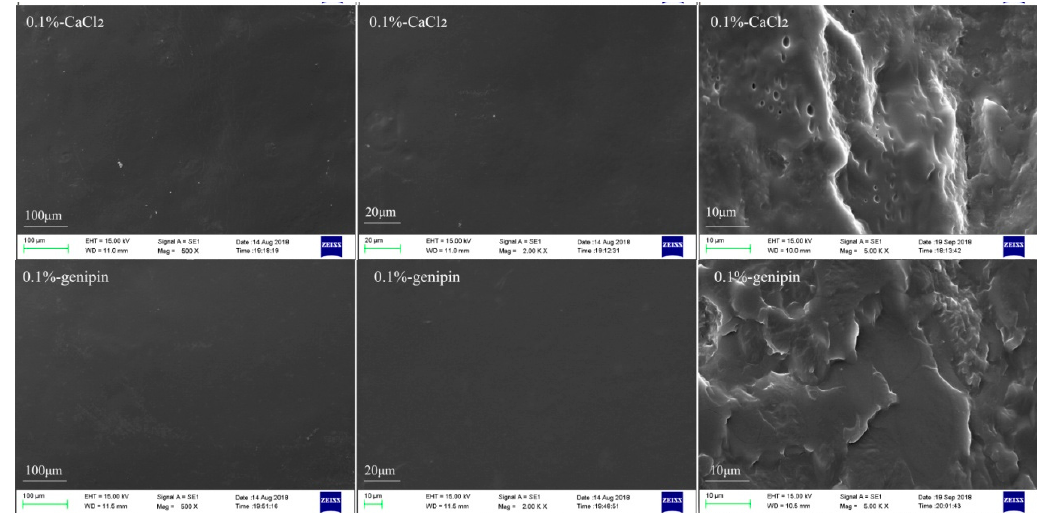
Figure 1. Representative SEM images revealing the surface morphologies ( left , 500 × ; center 2000 × ) and the fracture morphologies ( right , 5000 × ) of the blend films.